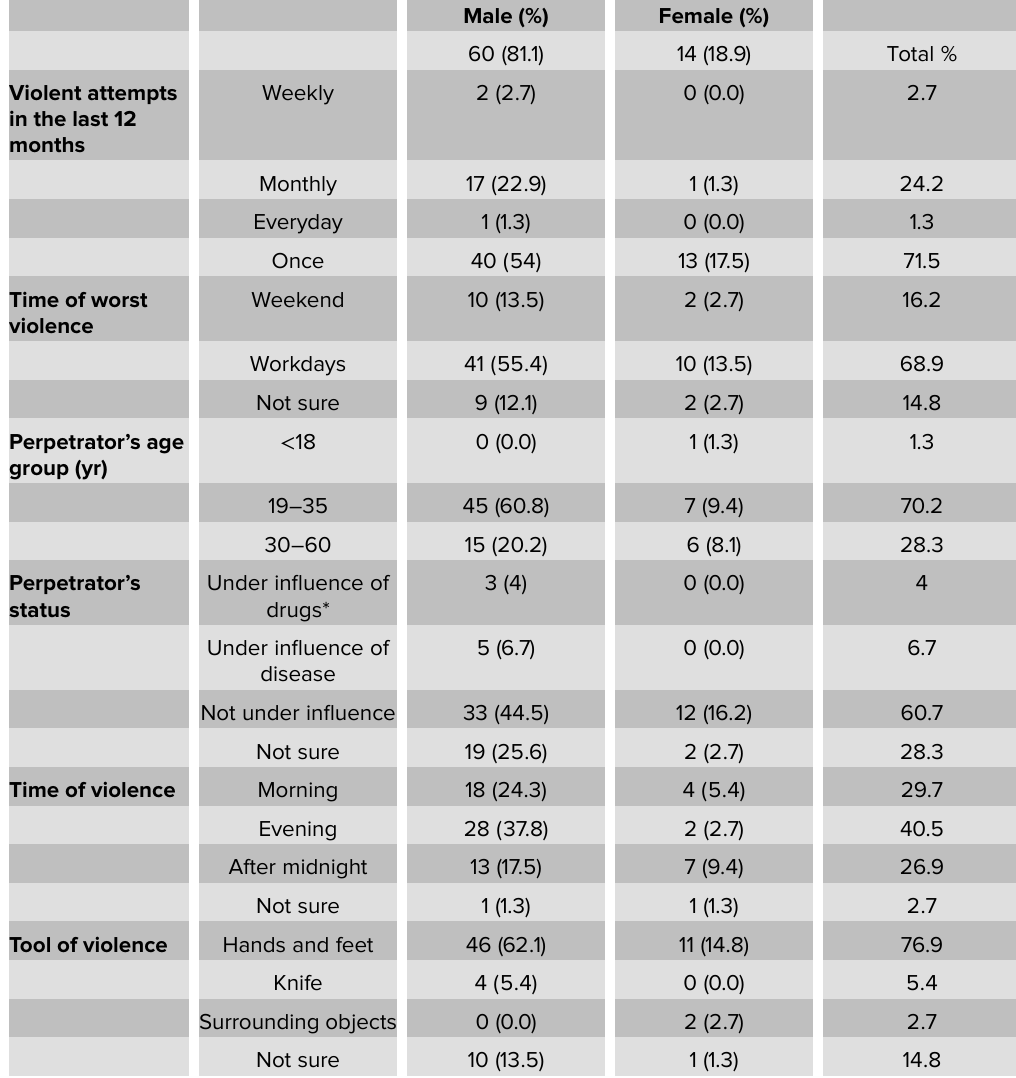
TABLE 3: Characteristics of